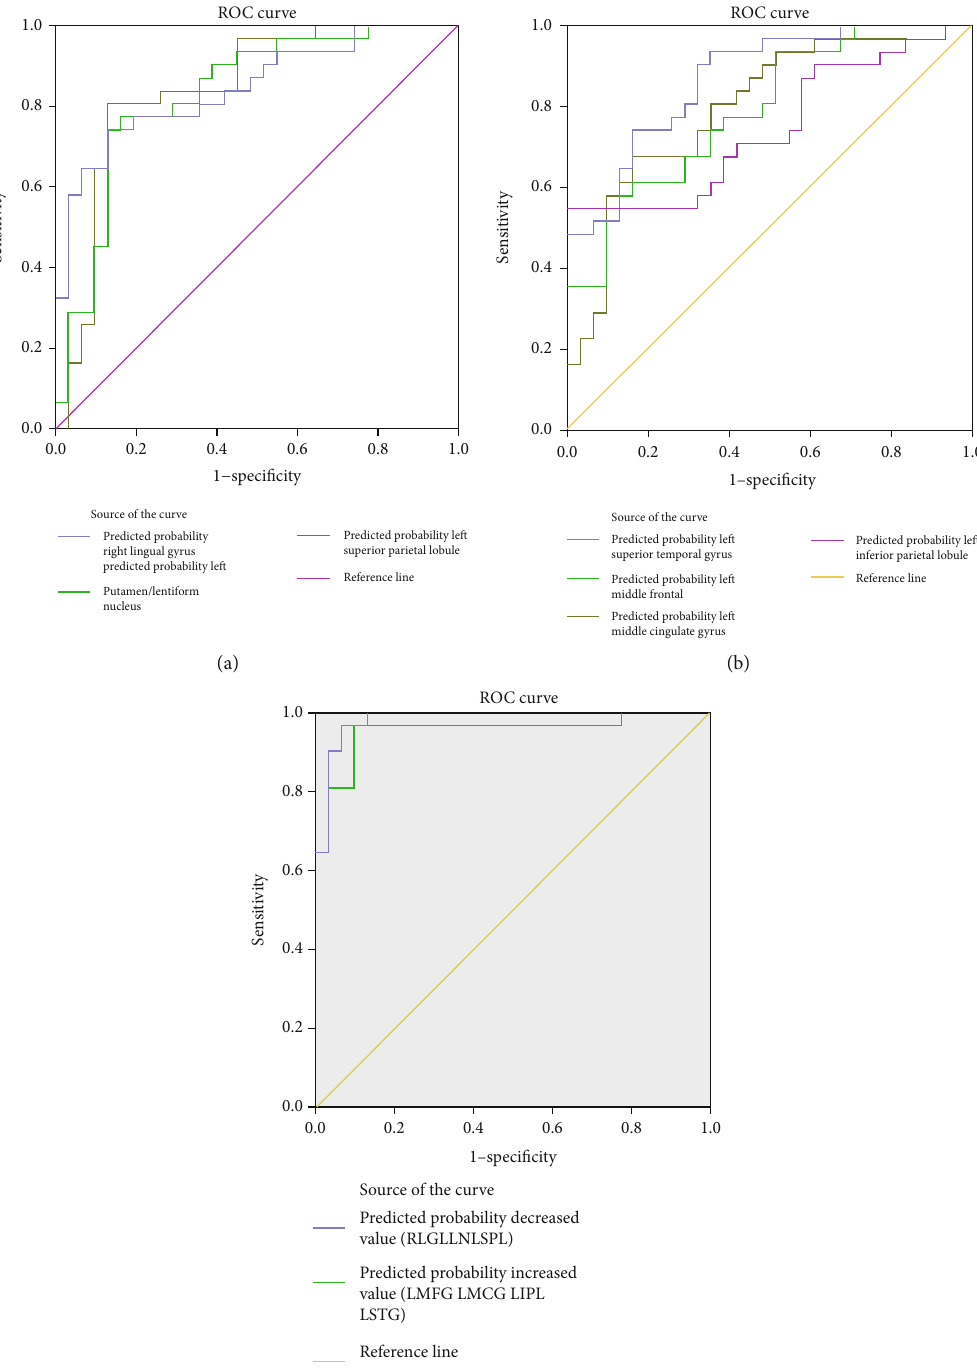
Figure 3: ROC curve analysis of the di ff erent ReHo values for abnormal brain regions in patients with NAION. (a) ROC curve for patient regions with high ReHo. The area under the ROC curve was 0.790 for the left middle frontal gyrus ( P < 0 : 0001 ; 95 % CI = 0 : 680 − 0 : 900 ), 0.797 for left the middle cingulated gyrus ( P < 0 : 0001 ; 95 % CI = 0 : 685 − 0 : 909 ), 0.869 for the left superior temporal gyrus ( P < 0 : 0001 , 95 % CI = 0 : 783 − 0 : 954 ), and 0.745 for the left inferior parietal lobule ( P < 0 : 001 ; 95 % CI = 0 : 620 − 0 : 870 ). (b) ROC curve for patient regions with low ReHo. The area under the ROC curve was 0.846 for the right lingual gyrus ( P < 0 : 0001 ; 95 % CI = 0 : 749 − 0 : 943 ), 0.843 for the left superior parietal lobule ( P < 0 : 0001 ; 95 % CI = 0 : 739 − 0 : 947 ), and 0.832 for the left putamen/lentiform nucleus ( P < 0 : 0001 ; 95 % CI = 0 : 728 − 0 : 937 ). (c) ROC curve for combined ReHo regions. The area under the ROC curve was 0.983 for the combined regions of low ReHo (see (a) for the regions) ( P < 0 : 0001 ; 95 % CI = 0 : 958 − 1 : 009 ). The area under the ROC curve was 0.954 for the combined regions of high ReHo (see (b) for the regions) ( P < 0 : 0001 ; 95 % CI = 0 : 899 − 1 : 009